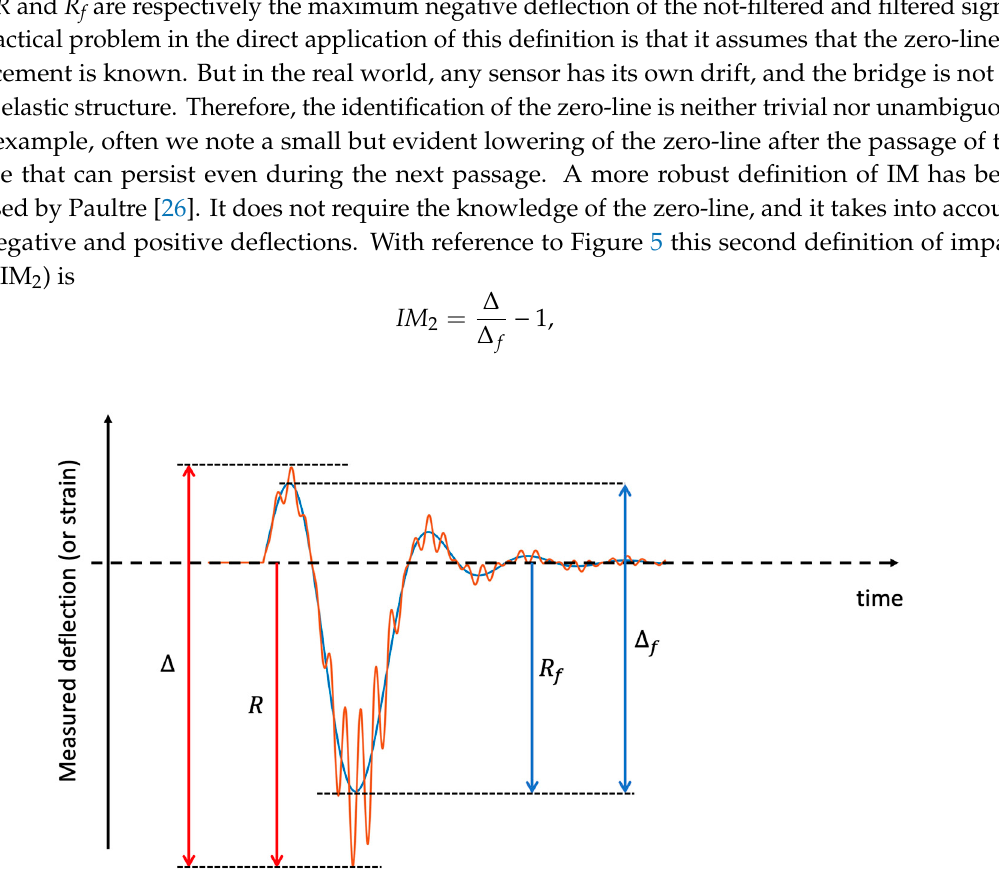
Figure 4. Radar installation at the Kaflan-Kuh Bridge.